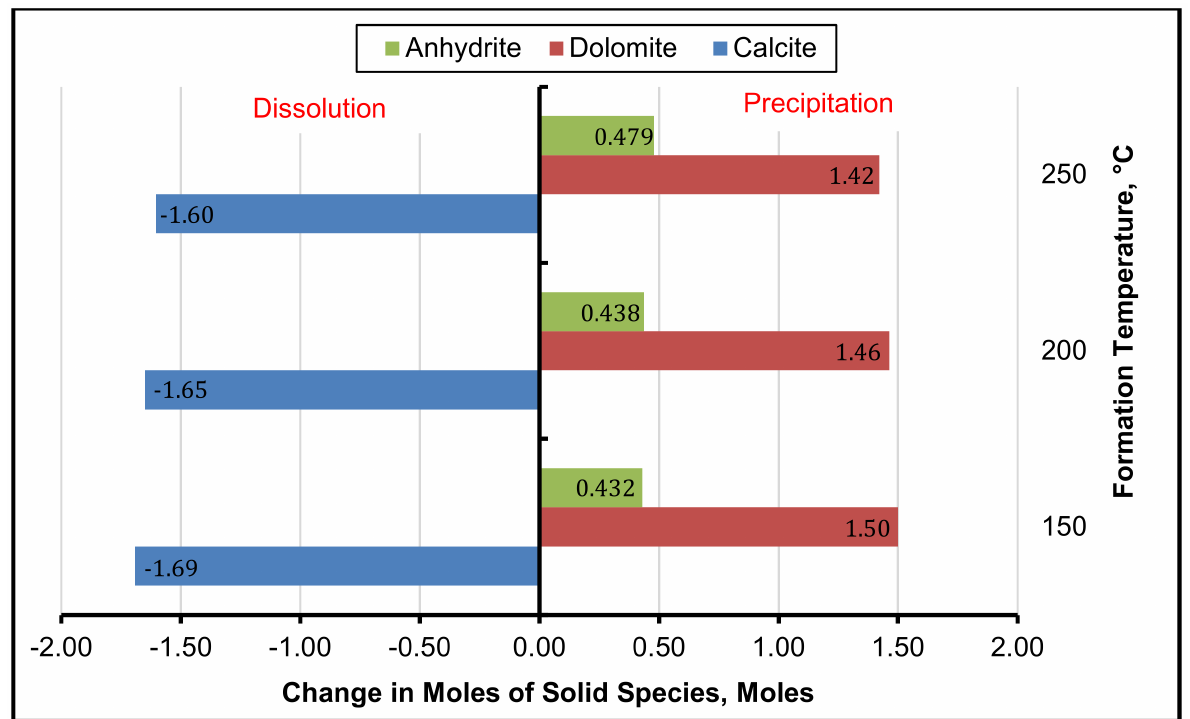
Figure 4. Formation temperature effect on the concentration of solid species for the first gridblock at 6 PVs with fixed water injection temperature of 100 ◦